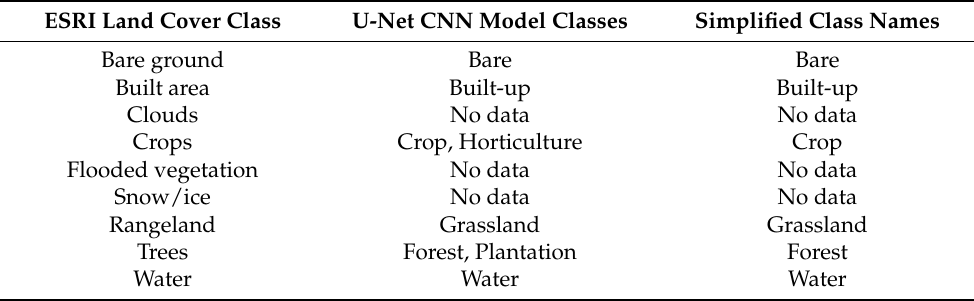
Table 4. Class correspondence table for ESRI Land Cover to U-Net CNN land